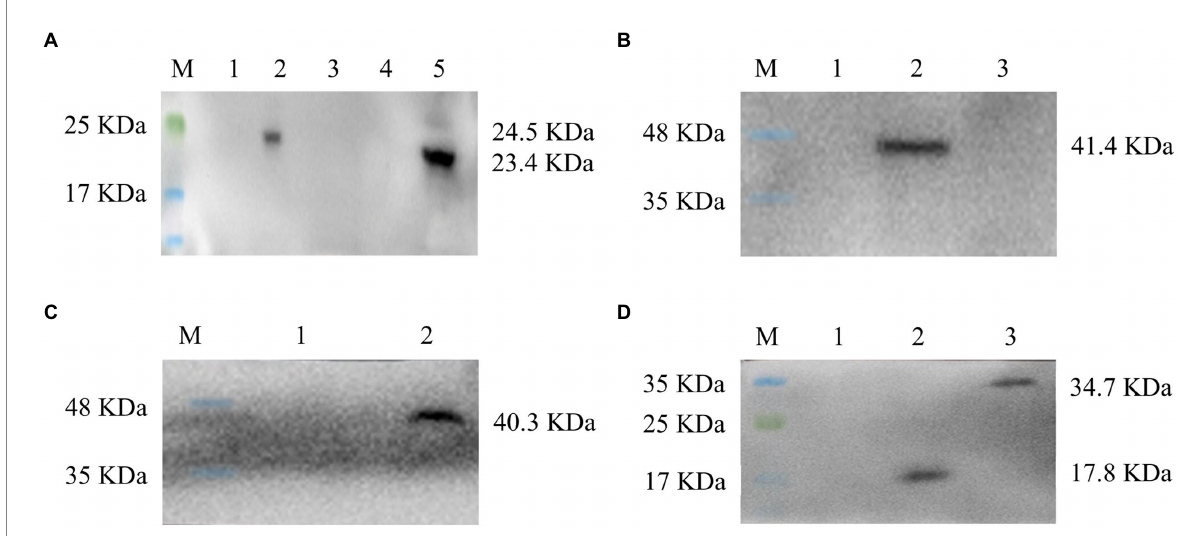
FIGURE 3 All six constructs, denoted as p30, p54, p72, p30-LTB, p54-LTB, and p72-LTB, were inserted into expression plasmid pMG36e and expressed in Lactobacillus . (A) The expressions of the recombinant L. lactis ASFV p30-His protein and p54-His protein were verified by Western blot, lane 1, 3–4: Negative control, lane 2: p30-His, lane 5: p54-His. (B) The expression of the recombinant L. lactis ASFV p30-LTB-His fusion protein was verified by Western blot, lane 1: Negative control, lane 2: p30-LTB-His. (C) The expression of the recombinant L. lactis ASFV p54-LTB fusion protein was verified by Western blot, lane 1–2: Negative control, lane 3: p54-LTB-His. (D) The expressions of the recombinant L. lactis ASFV p72-His protein and p72-LTB-His fusion protein were verified by Western blot, lane 1: Negative control, lane2: p72-His, lane 3: